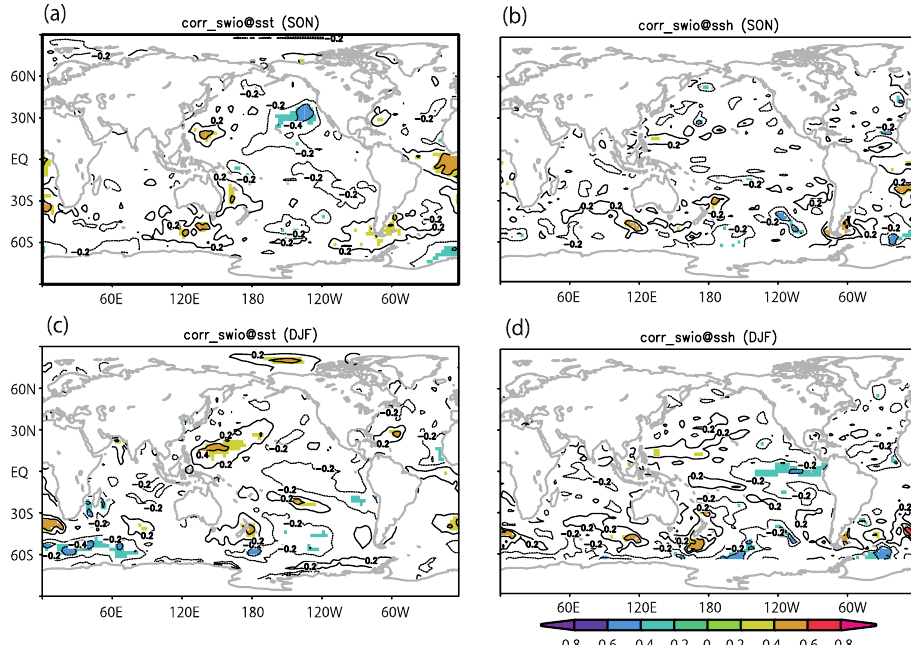
Figure 9. Lead-lag correlation map of SST (left panels) and SSH (right panels) anomalies to MAM observed TCF anomaly (defined as occurrence in 5° × 5° bins, units are TCs per season) over the SWIO region (averaged over 10 – 30° S, 40 – 70° E). Significant areas above 90% are shaded. ( a ) SON SST, ( b ) SON SSH, ( c ) DJF SST, ( d ) DJF SSH.